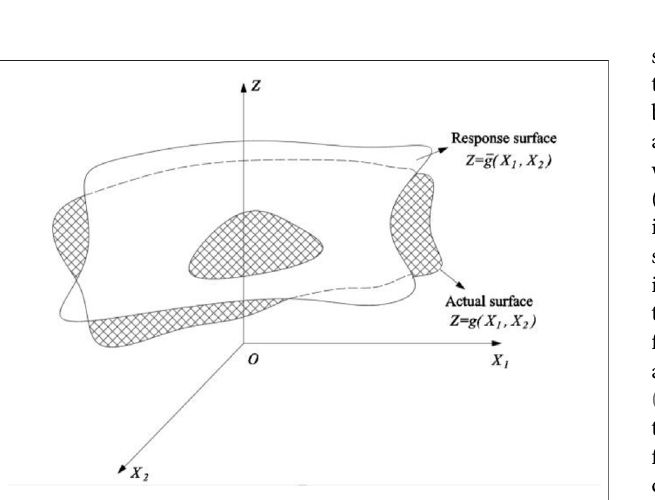
FIGURE 3 | Response surface